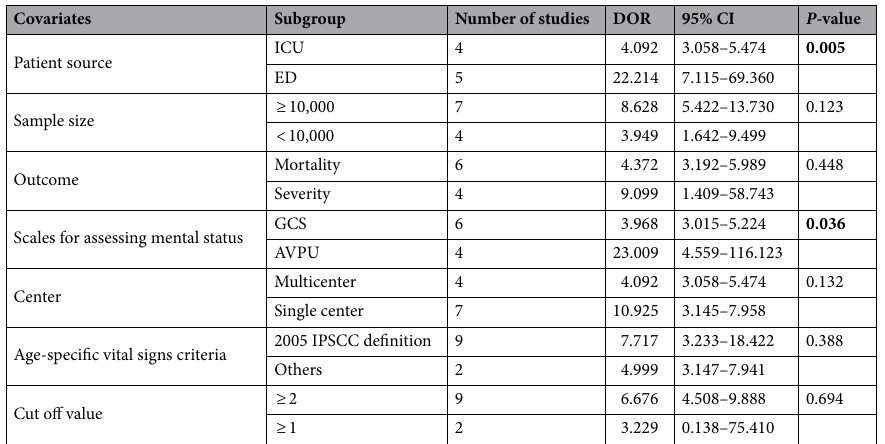
Table 2. Subgroup analysis. Bold values denote statistical significance at the P < 0.05 level. AVPU, Alert, Voice, Pain, Unresponsive scale; CI, confidence interval; DOR, diagnostic odds ratio; ED, Emergency Department; GCS, Glasgow Coma Scale; ICU, Intensive Care Unit; IPSCC, International Pediatric Sepsis Consensus Conference.